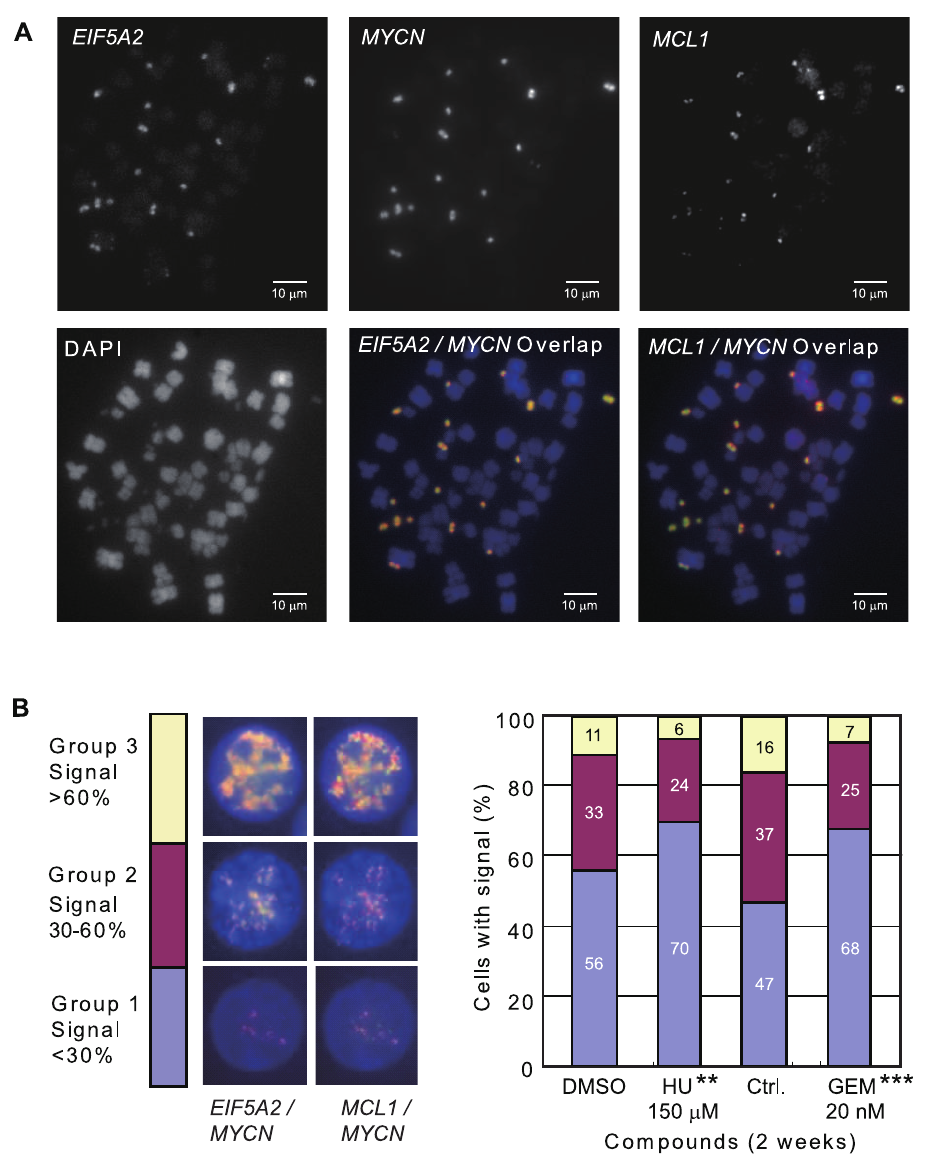
Figure 2. The signal of EIF5A2 , MYCN, and MCL1 genes is decreased in HU and GEM treated UACC-1598. A. Genes EIF5A2 , MYCN , and MCL1 are present on DMs in UACC-1598 cells. Metaphase spread of UACC-1598 cells detected with DNA probe for EIF5A2 , MYCN , and MCL1. For the overlapped pictures, EIF5A2 and MCL1 signals are shown in red, and MYCN signal is shown in green. Overlapped EIF5A2 / MYCN and MCL1 / MYCN are shown in yellow. B. Representative pictures of EIF5A2 / MYCN and MCL1 / MYCN FISH signals in interphase cells of UACC-1598 and how individual cells are separated into different groups. MYCN signal is shown in green, EIF5A2 and MCL1 shown in red, and the overlap is shown in yellow. The percentage of cells in Groups 1, 2, and 3 is based on EIF5A2 / MYCN and MCL1 / MYCN FISH signals. The statistical analysis showed the differences of cells in Group 1 and Group 2/3 compared to the control cells. *denotes a P value of 0.01 to 0.05 and **denotes a P value of 0.001 to 0.01.